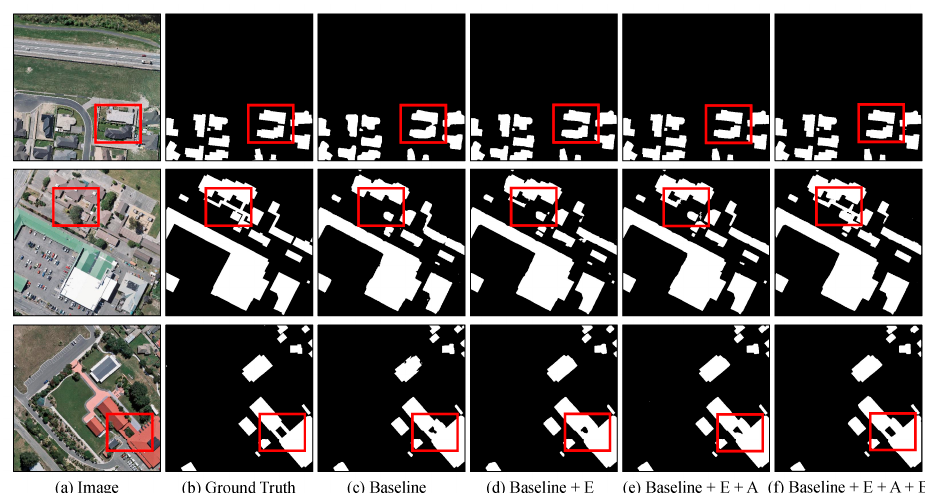
Figure 10. Ablation study results using the WHU dataset.